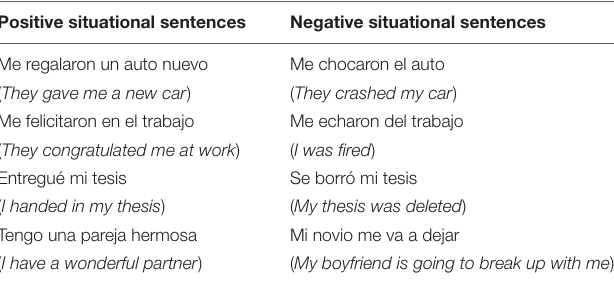
TABLE 1 | Examples of positive and negative situational sentences.